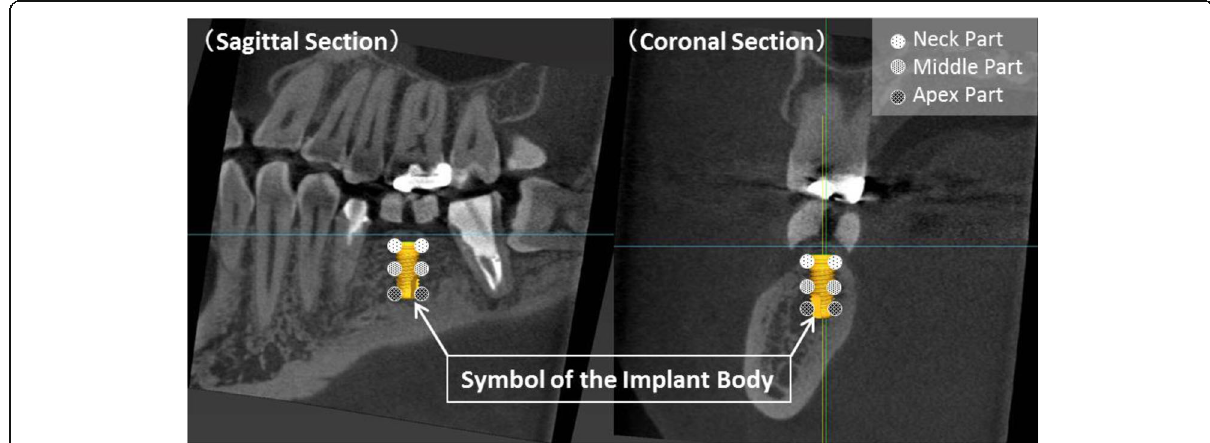
Fig. 2 The measurement of the voxel values. A case of bone quality diagnosis before treatment. Width and height of the bone were measured to select the proper size of the implant body. The selected implant body was simulated on the bone images as a symbol, and then the voxel value was calculated as described in the “ Methods ”